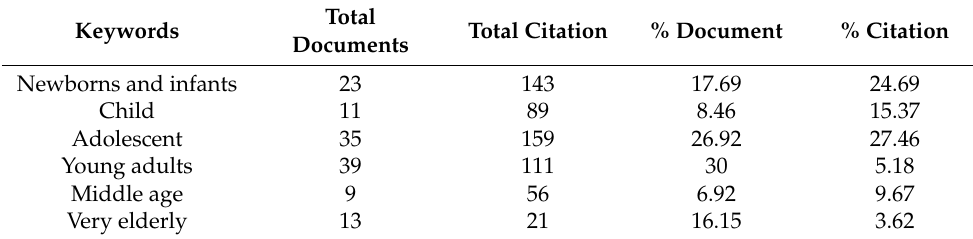
Table 3. Focus on women’s age